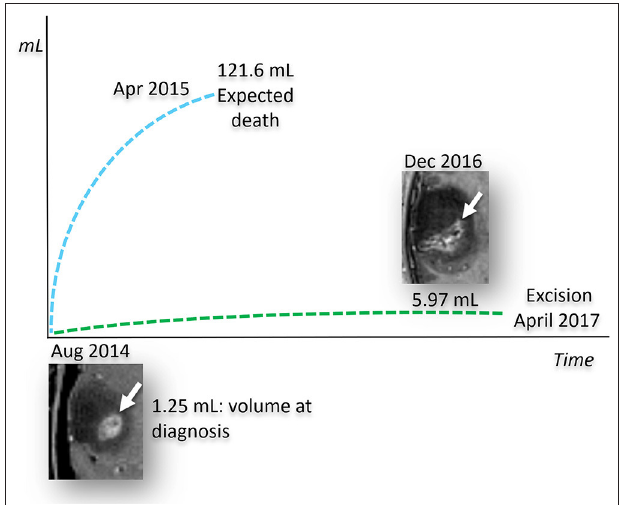
FIGURE 5 | Predicted and observed tumor volume for untreated IDH1 -mutant GBM. Measured growth of the patient’s tumor compared to its estimated growth, based on the stochastic model of untreated human glioblastomas ( 84). The size of the tumor, measured at diagnosis in August 2014, is calculated by measuring the post contrast images only, since the current literature does not provide growth models based on the total volume of the tumor represented by the enhancing and non-enhancing tumor. Based on this stochastic model, the predicted growth rate (blue dashed line), shows that the enhancing tumor would have reached a volume incompatible with life around April 2015. In striking contrast to what was expected, the patient’s IDH1 mutant GBM, treated with the KMT alone, demonstrated a much lower growth rate (green dashed line). It should be noted that over 70% of the patient’s GBM did not enhance as would expected for IDH mutation. The patient’s tumor volume measurements were determined from MRI, as described in